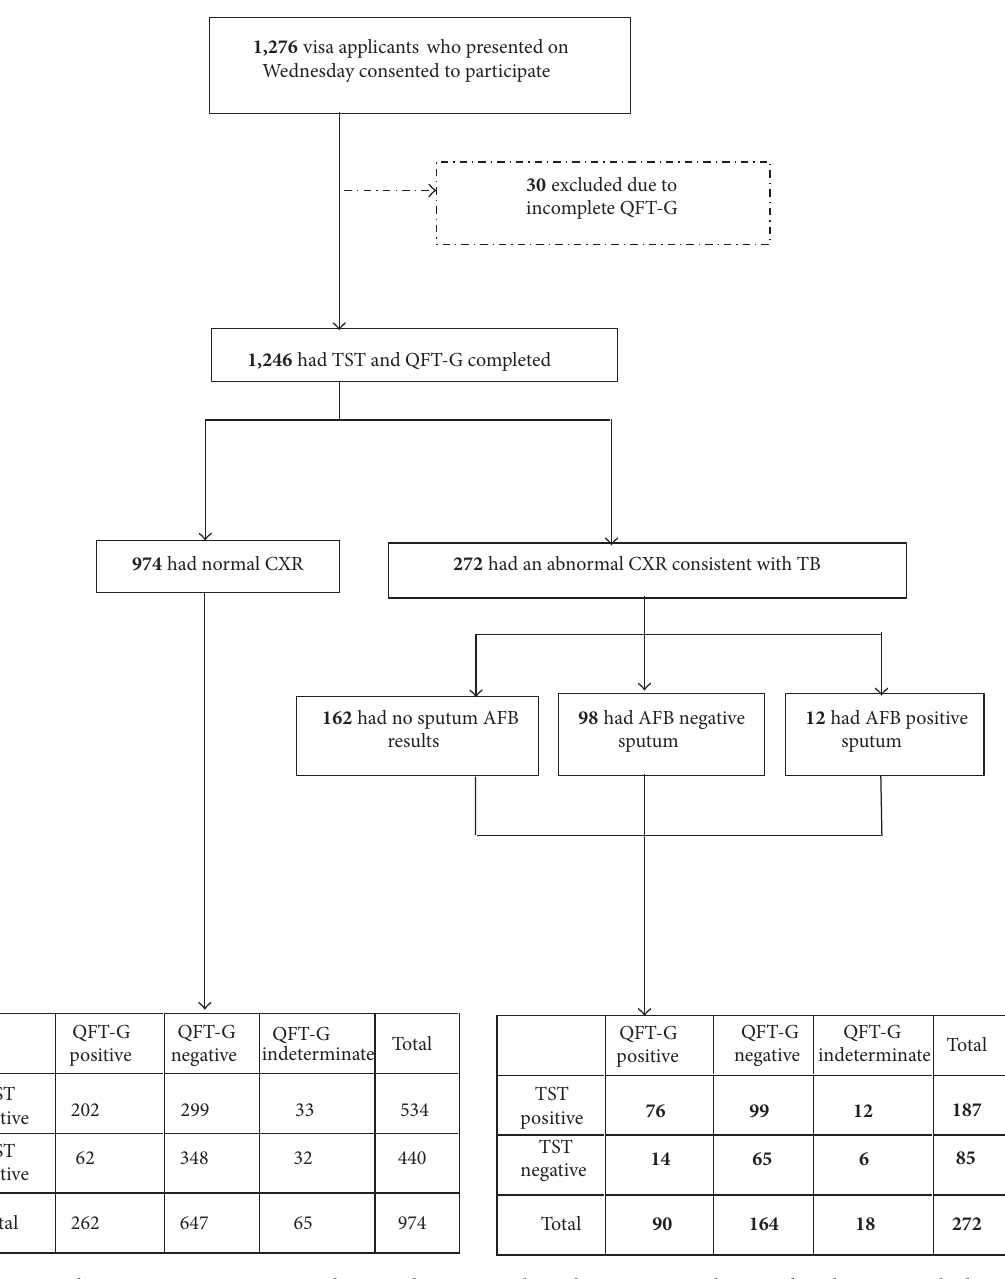
Figure 1: Participation diagram. Immigrant visa applicants who presented to Cho Ray Hospital on Wednesdays were asked to participate. QFT-G: QuantiFERON-TB Gold test; TST: tuberculin skin test; CXR: chest radiograph; TB: tuberculosis; AFB: acid fast